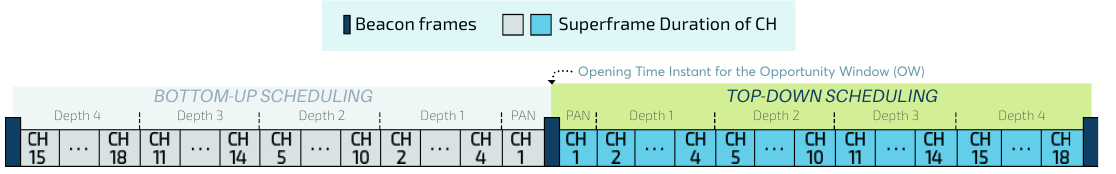
Figure 8. Rescheduling model addressed for prioritisation different